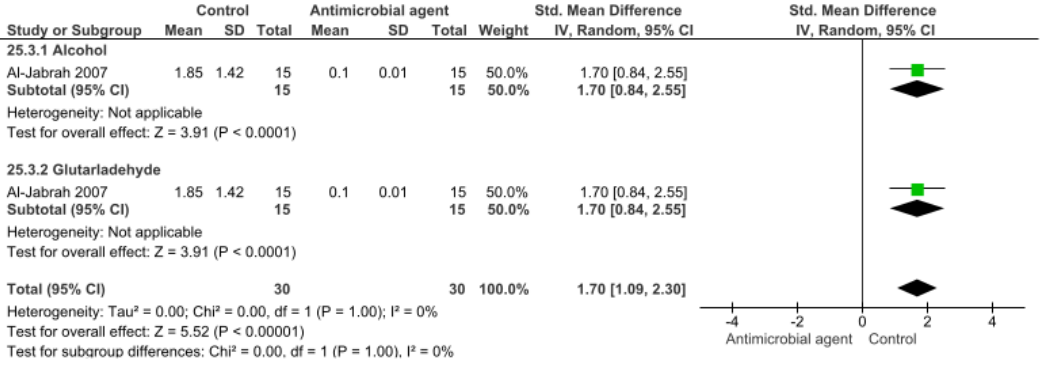
Figure 4. Forest plot of the analysis of CFU/mL count in polyether after disinfection.